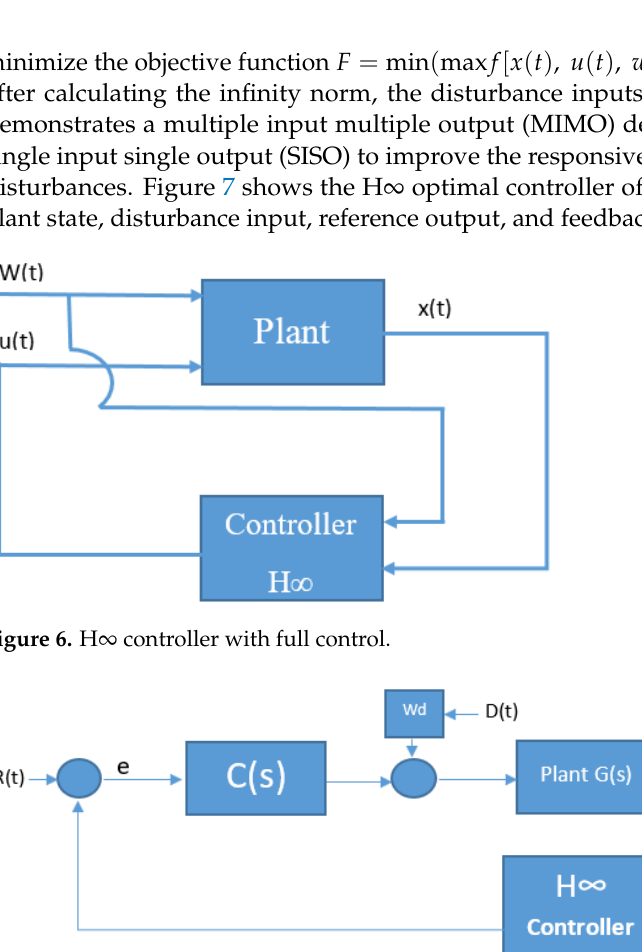
Figure 7. The closed-loop system with the H ∞ controller.